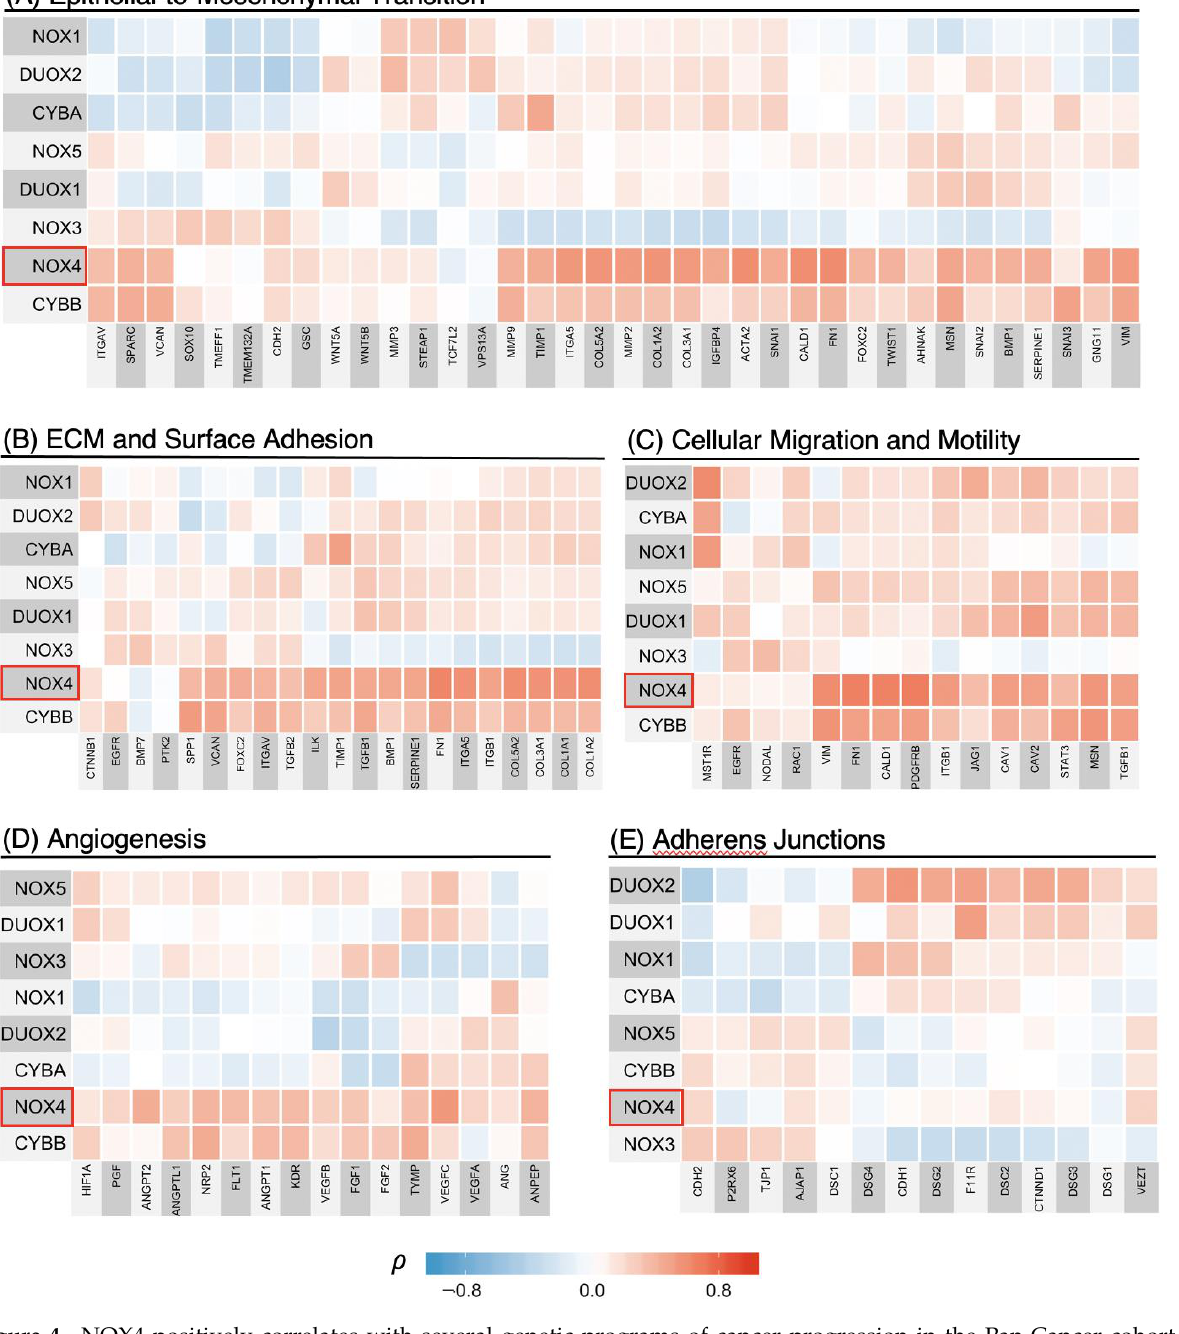
Figure 4. NOX4 positively correlates with several genetic programs of cancer progression in the Pan-Cancer cohort. Spearman’s rank correlation coefficients, ρ , were calculated and mapped to assess the relationships between individual NADPH oxidases and various genetic programs of cancer progression, such as epithelial-to-mesenchymal transition (EMT), extracellular matrix (ECM)/surface adhesion, cell migration and motility and angiogenesis (( A – D ), respectively) using the Final Pan-Cancer Dataset. NOX4 expression shows strong positive correlations with genes in programs ( A – D ), but poor correlations with epithelial marker genes in ( E ). The direction of correlation is indicated by the color: blue is a negative whereas red is a positive correlation, and the strength of the correlation is represented by the color intensity. Genes listed with each program and their corresponding functions in cancer are provided in Table S1.